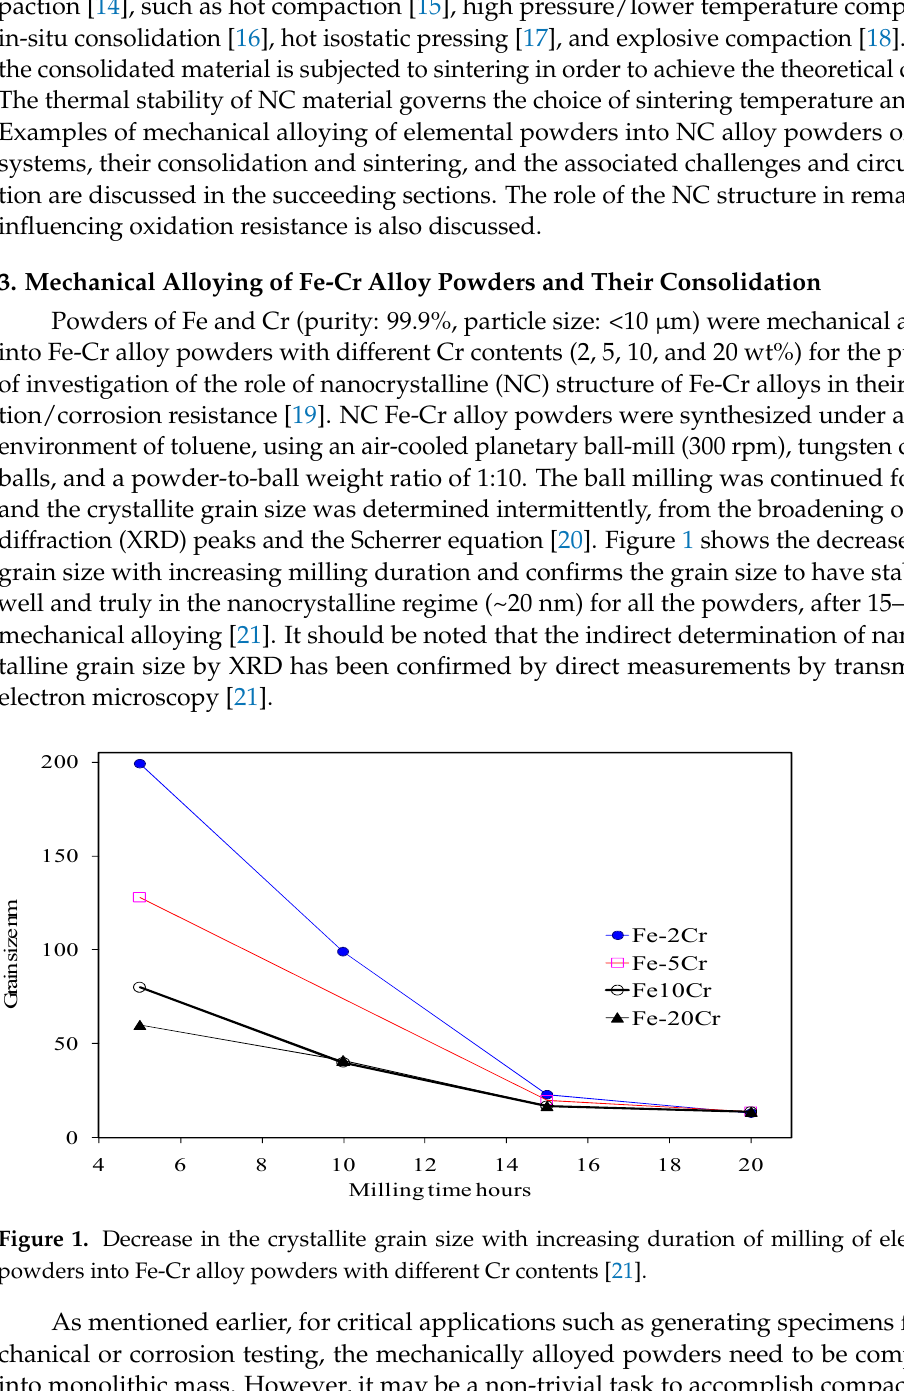
Figure 2. XRD spectra for mechanically alloyed Fe-10Cr alloy annealed for different durations (0– 120 min) at 500 °C ([24], reproduced with copyright clearance).